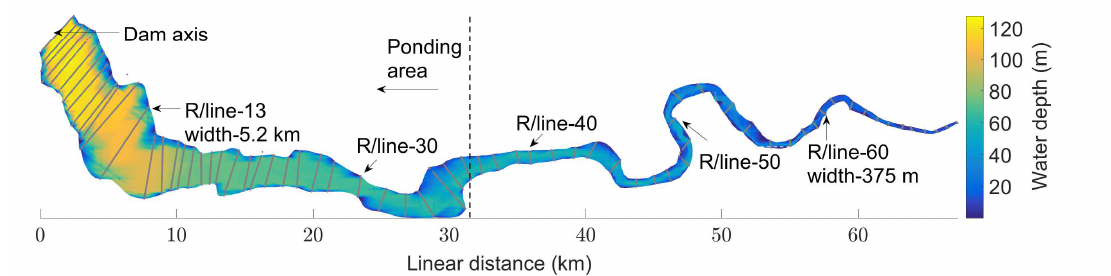
Figure 4. Measured data points (grey) along cross sections/range lines and TELEMAC simulated water depth at 30 September